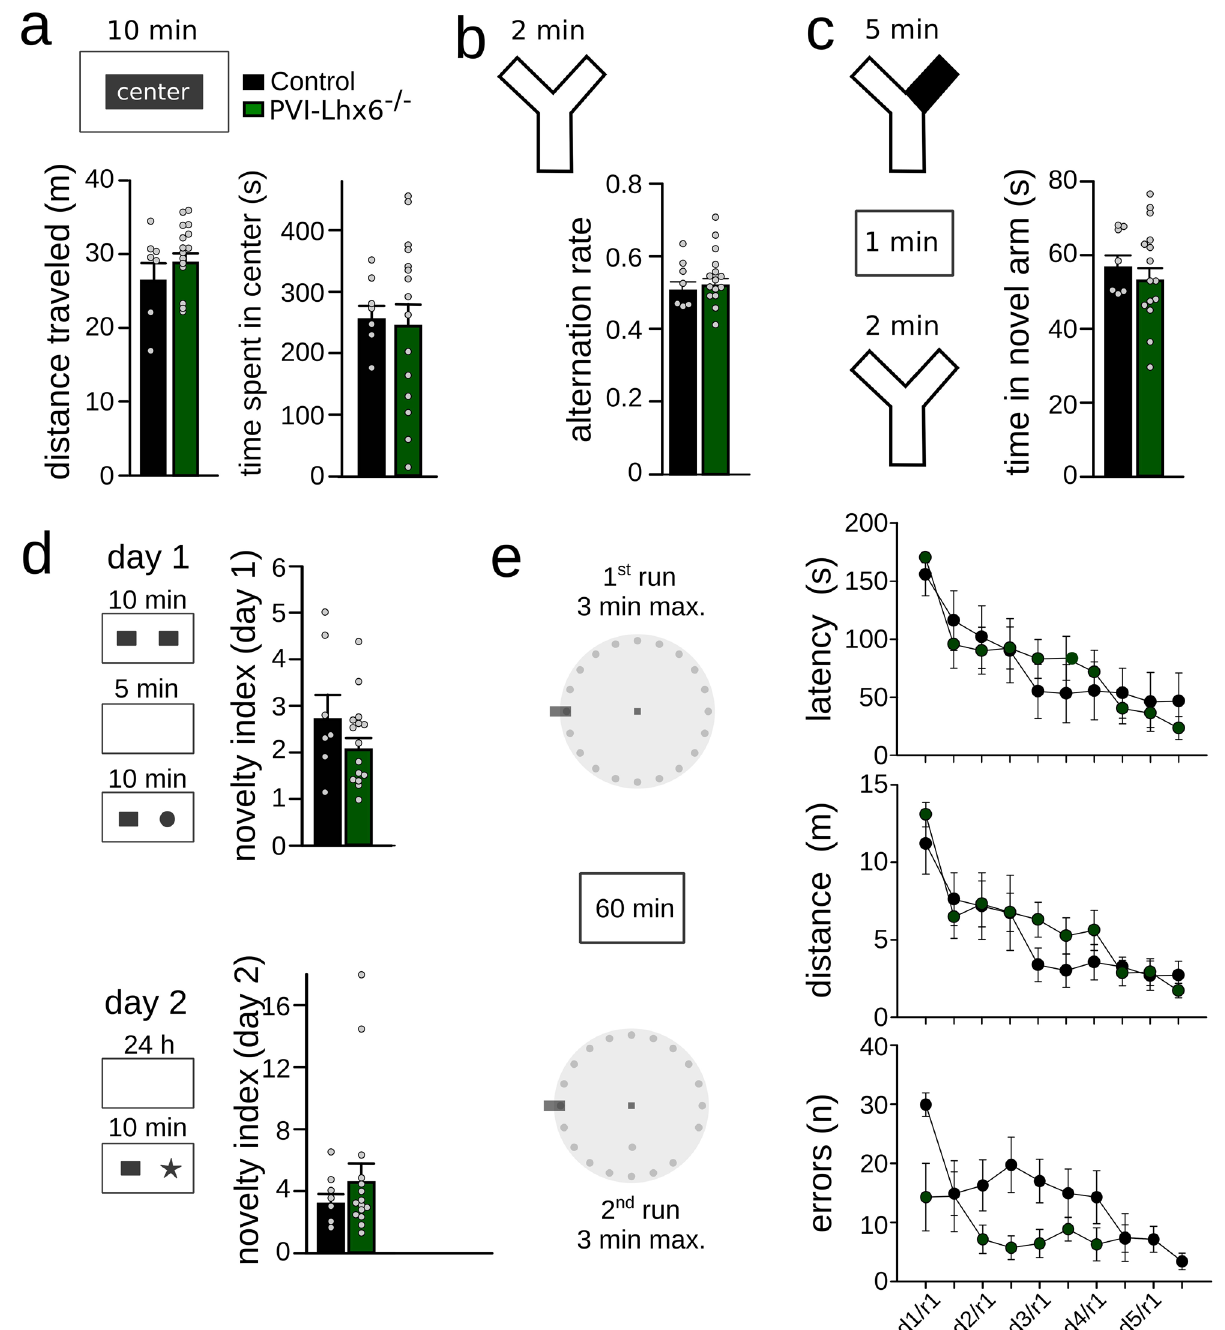
Figure 5. Intact cognitive behavior upon postnatal removal of Lhx6. ( a ) Open field task. PV-Lhx6 −/− mice displayed similar total distance travelled (left) and time spent in the center of the arena (right), indicating unaltered motor behavior and anxiety levels. ( b ) Spontaneous alternation task. There was no significant difference in the alternation rate of PV-Lhx6 −/− mice. ( c ) Novel arm exploration task. Left: schematic of the procedure. Right: during the test phase, PV-Lhx6 −/− mice spent equal times in the novel as control animals. ( d ) Novel object task. Left. Schematic of the procedure. Right: quantification of the novelty index for 5 min (top) and 24 h delay periods (bottom) indicated unchanged object recognition in PV-Lhx6 −/− mice. ( e ) Barnes maze task. Left: schematic of the test. Right: quantification of latency to the escape tunnel (top), distance travelled (middle) and errors (bottom) revealed intact spatial learning in PV-Lhx6 −/− mice. Data points show mouse averages. Data are mean ± sem. Schematics were created with Inkscape 0.92 (www. inksc ape.